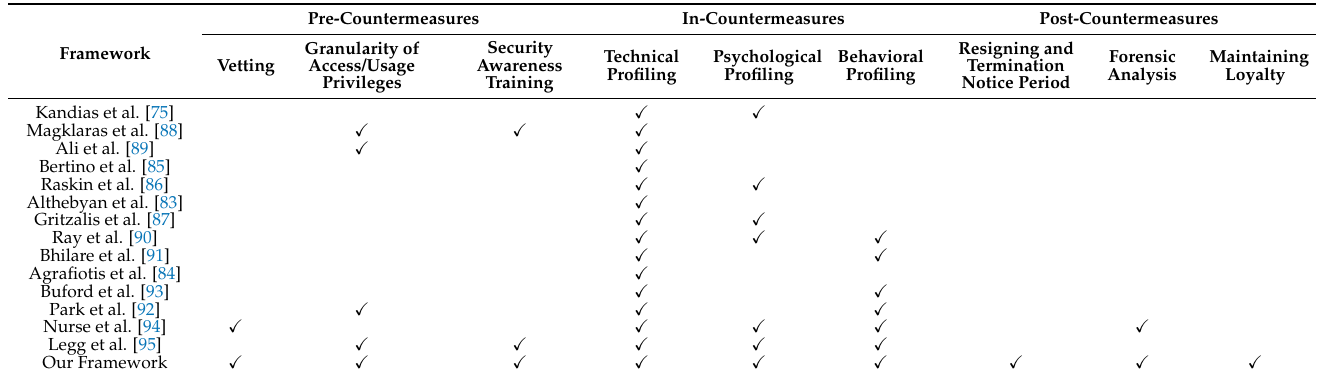
Table 9. The existing frameworks compared to